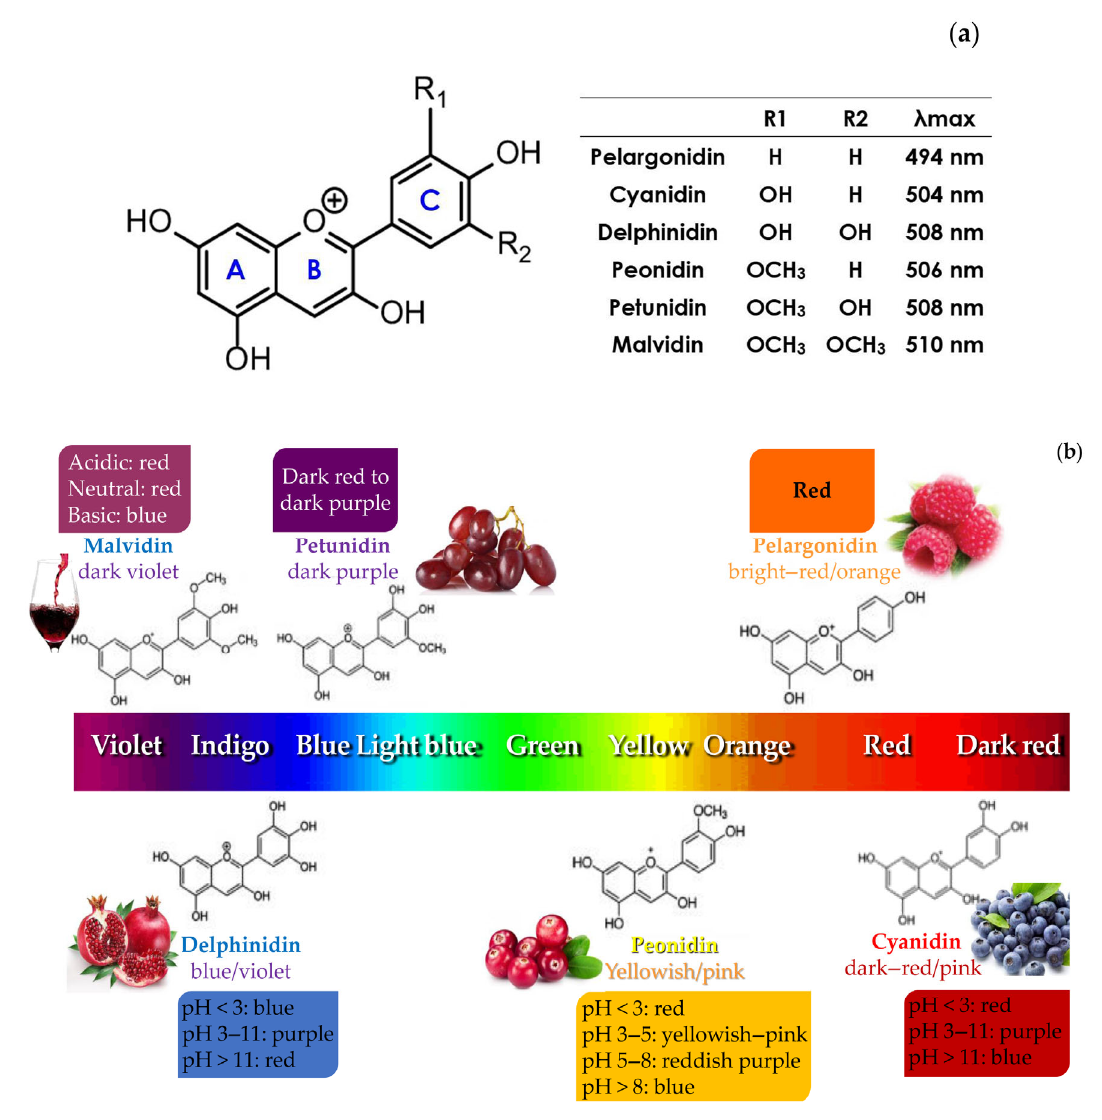
Figure 1. ( a ) Basic skeleton and major ACNs in plants, with respective maximum wavelength; ( b ) Spectral absorbance ranges for the most-abundant anthocyanins and respective colour at different pH values.